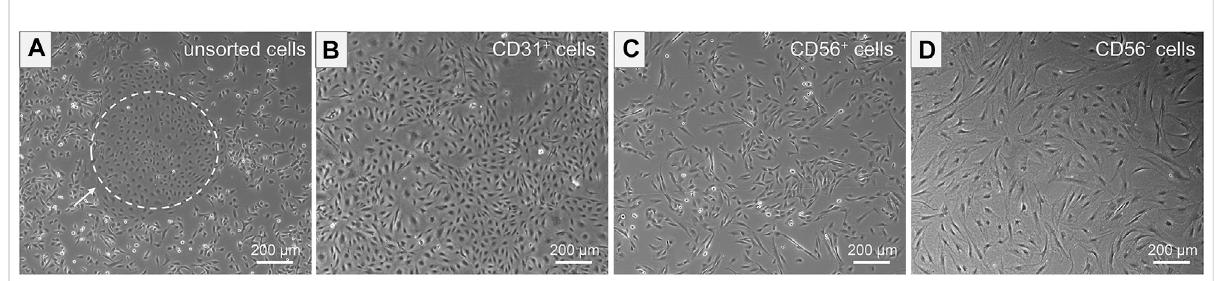
FIGURE 4 Morphology of isolated cells. Microscopic images represent the morphology of the different isolated cell types. (A) Unsorted cells containing multiple cell types of distinct morphologies. Dashed white circle indicates SkMVECs. (B) Isolated CD31 + cells, SkMVECs, displaying a typical round, cobblestone-shaped morphology. (C) Isolated CD56 + cells, satellite cell-derived myoblasts, appearing as more elongated, oval-shaped cells. (D) Remaining CD56 − cells, including fi broblasts and pericytes, displaying a larger cell size and irregular shape, partially with protrusions.